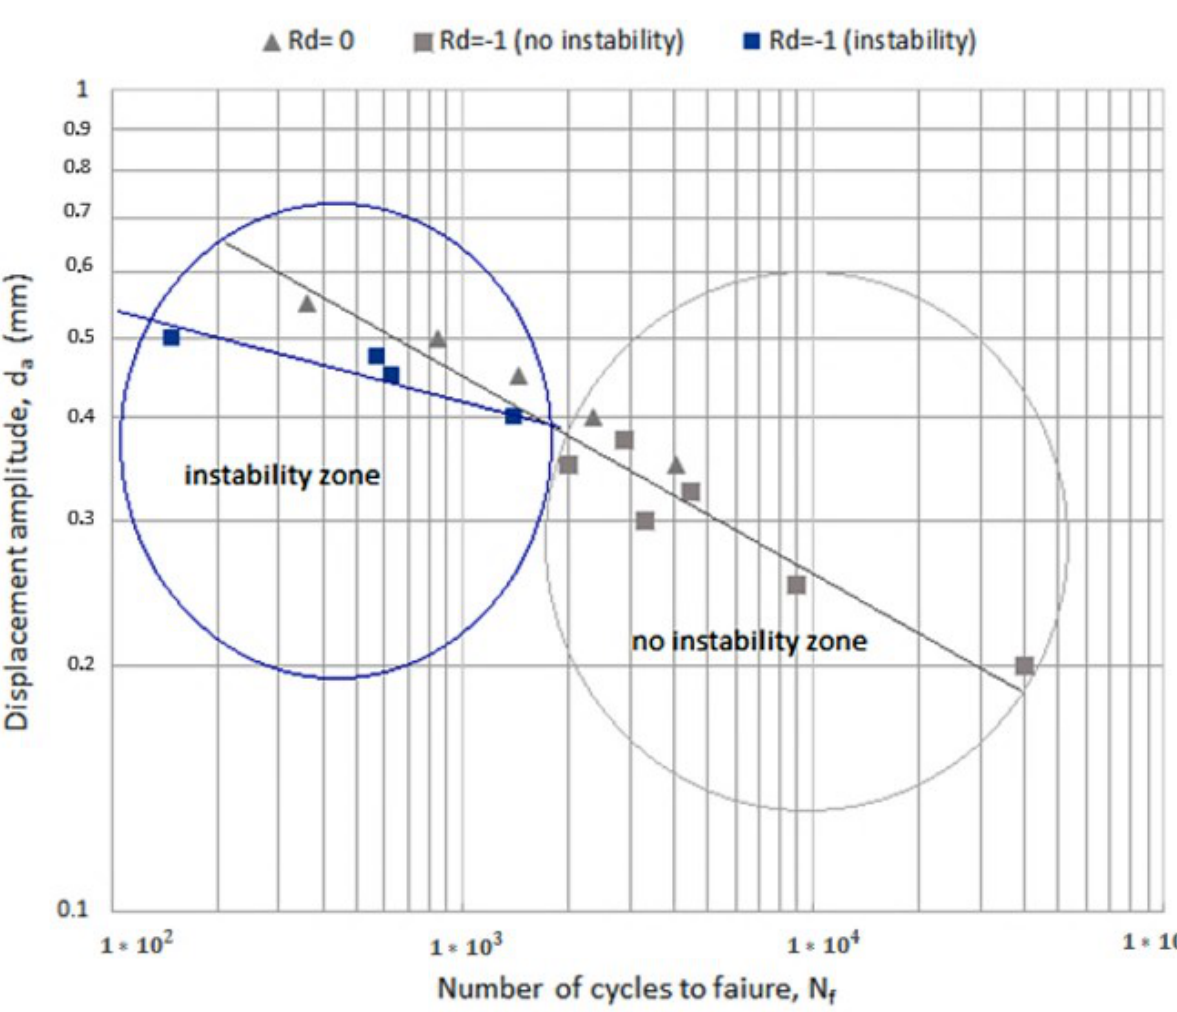
Figure 13. d a − N f curve (results at R d = 0 and R d = −